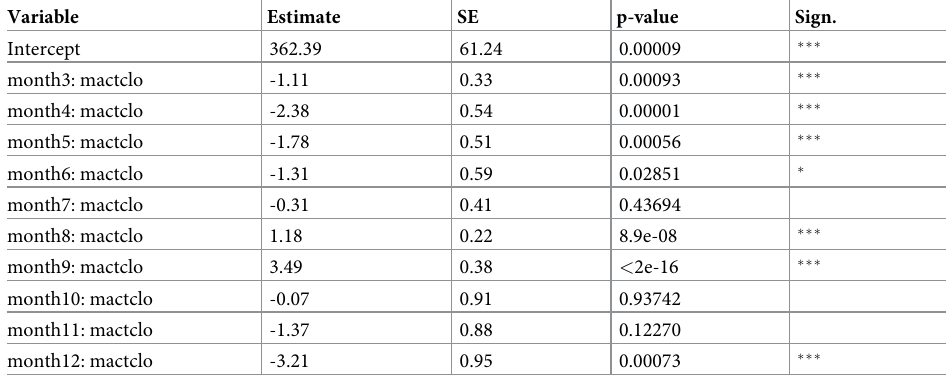
Table 4. Linear mixed-effects model explaining distance of black grouse GPS locations towards closed routes in dependence of season and seasonal human activity. Variable Estimate